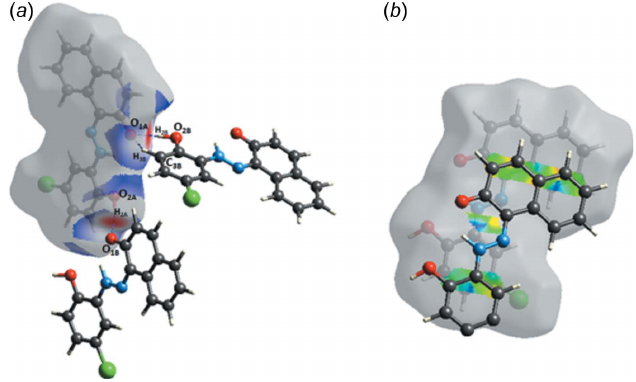
Figure 6 Hirshfeld surface mapped over d norm for the title compound showing: ( a